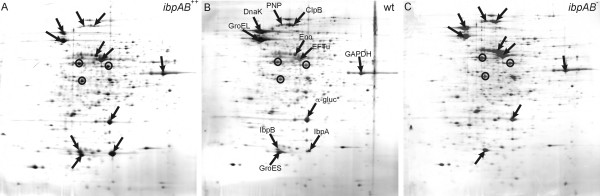
Effect of ibpAB availability on the proteome composition after two hours of α-glucosidase production at 42°C. After growth at 37°C to OD600 of 0.5, cultures were induced with 1 mM IPTG, and transferred to 42°C. Two hours later, cells were harvested and the proteome was separated by two-dimensional gel-electrophoresis. Silver-stained two-dimensional gels of (A) wildtype strain with or (B) without ibpAB overexpression, and of (C) the ibp AB deletion strain. Reference spots used for normalisation of spot intensities after densitometry are indicated by circles. Positions of selected proteins (cf. text) are indicated.